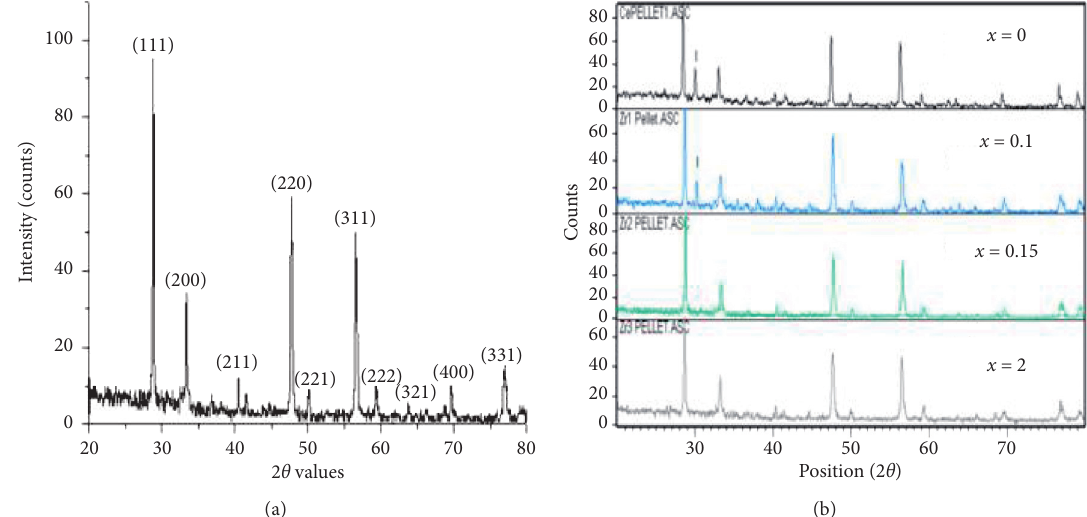
Figure 1: X-ray difraction pattern for (a) Ce Table 2: Crystallite size, lattice parameter, and porosity of CeZr